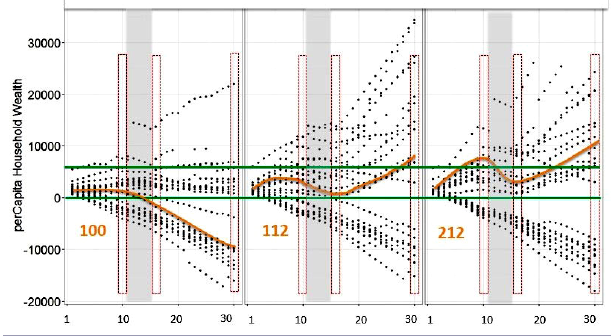
Fig. 2 . Examples of household development trajectory. Three panels are from three individual simulation scenarios. The x- axis represents the simulation year and y is the per capita household wealth. Every black dot is one specific household’s per capita wealth Y at year X, and the line shows one single household wealth trajectory over one year. The three rectangles with red dashed lines indicate the time point that we record household’s state, which are Year 10 (before shock), 16 (after shock), and 30 (at the end of simulation). The two green lines indicate the two thresholds that distinguish the three livelihood states. The gray panel is when a shock is applied to the simulation during year 11 and 15.